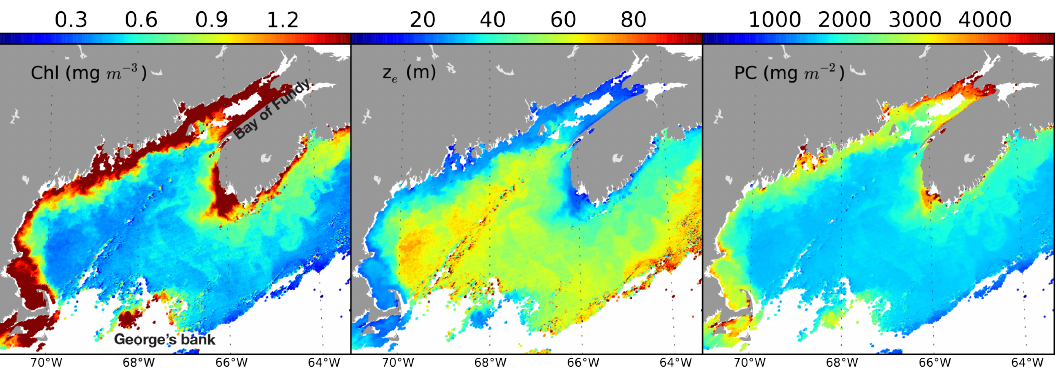
Fig. 1. Left panel shows Chl- a from MODIS Aqua satellite platform on 2 February 2005. The center panel is the euphotic depth z e at the same time, calculated as z e = log e ( 0 . 01 )/K 490 using the MODIS K 490 fields. In the right panel, PC is calculated using the former fields and a fixed C:Chl ratio of 60 as PC = Chl- a · ( C:Chl ) · z e . A constant C:Chl ratio is used to derive PC only for the sake of this figure and the next; a dynamic C:Chl ratio is used when calculating NCP e .